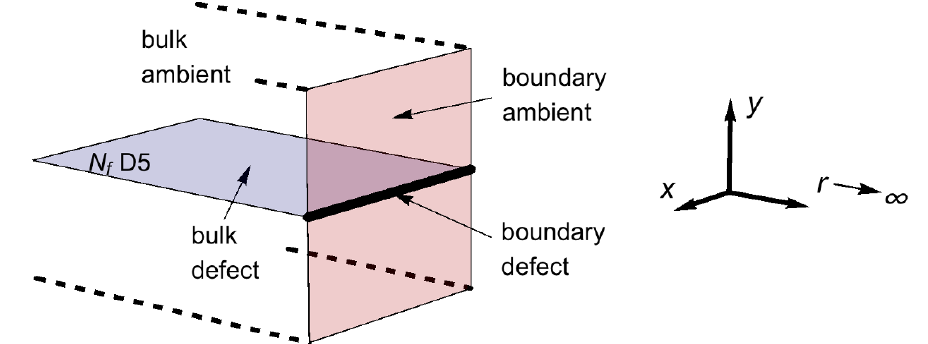
Figure 2 . The defect AdS/CFT correspondence. The bulk theory consists of an ambient IIB string theory on AdS 5 (cid:2) S 5 , coupled to a defect composed of probe D5-branes. The boundary theory consists of an ambient N = 4 SYM on R 1 ; 3 coupled to a co-dimension one defect hosting localized